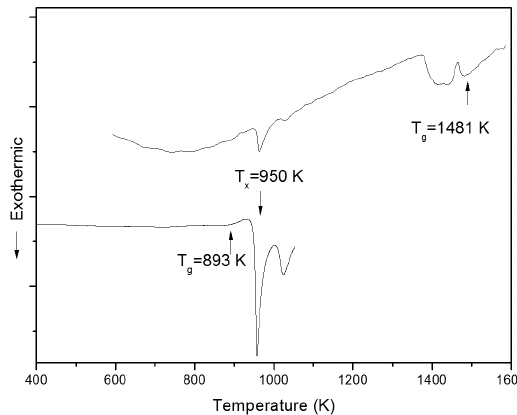
Co Cr Mo Nb Si B Y 47 7 15 4.5 4,5 5 15 2 , onset of crystallization g , and γ parameter of l